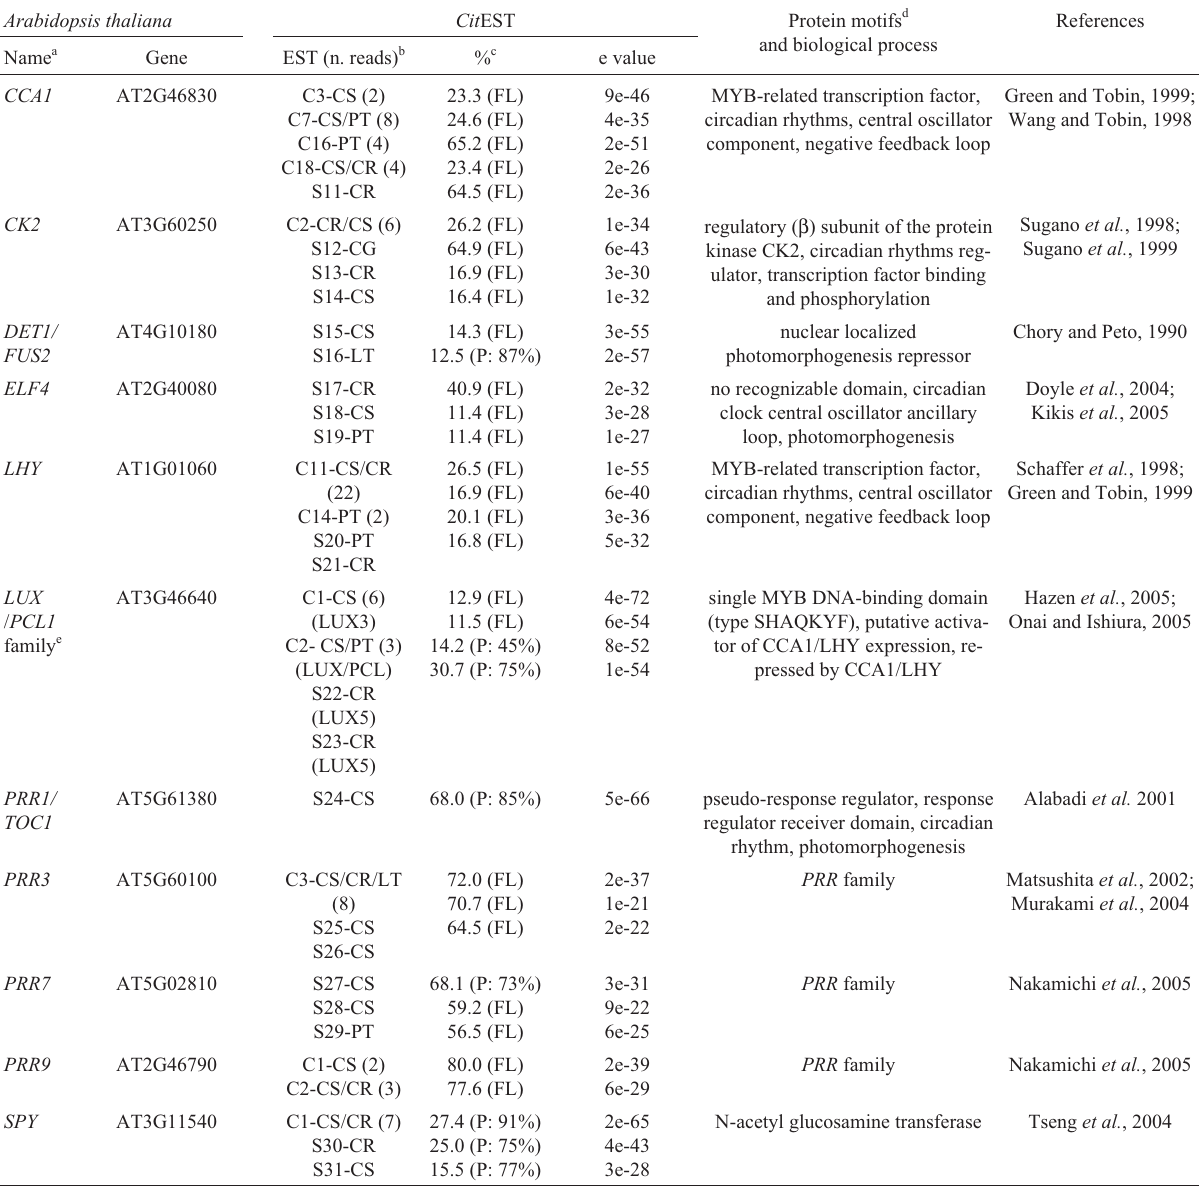
Table 2 - Citrus ESTs with homology to genes involved in the central oscillator of the circadian clock in Arabidopsis thaliana . Arabidopsis thaliana Cit EST Protein motifs d